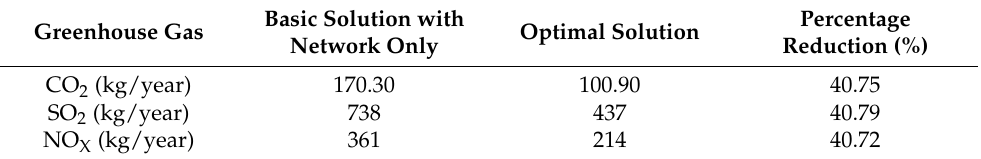
Table 11. Comparison between the optimal and the original baseline system in terms of greenhouse gas emissions.